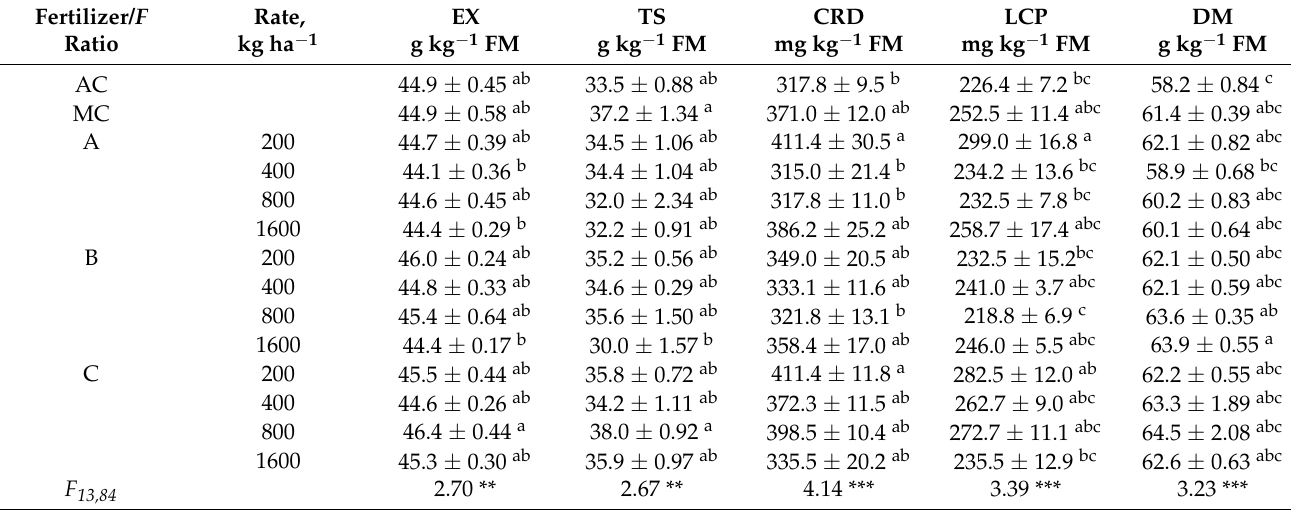
Table 7. Effect of bio-fertilizer application on content of dry matter and organic compounds (mean ± standard error). Fertilizer/ F Rate, Ratio